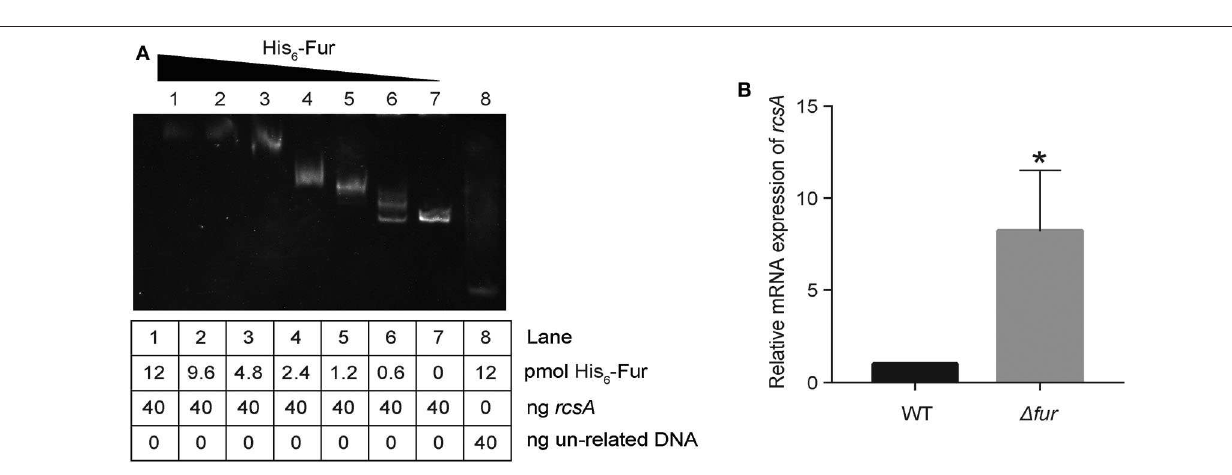
Frontiers in Cellular and Infection Microbiology |